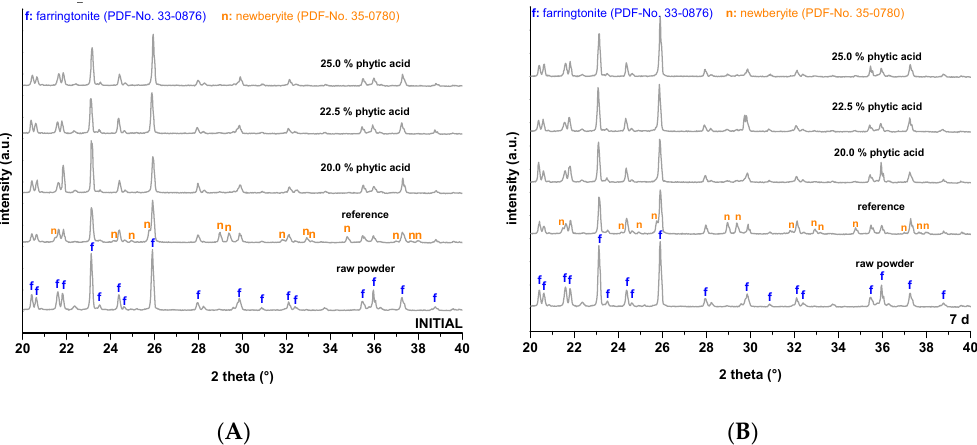
Figure 1. Compressive strength of cement cuboids made from farringtonite and 2.0 M phosphoric acid (reference) respectively 20.0, 22.5 or 25.0% phytic acid initially or after 24 h respectively 7 d hardening in PBS at 37 °C.